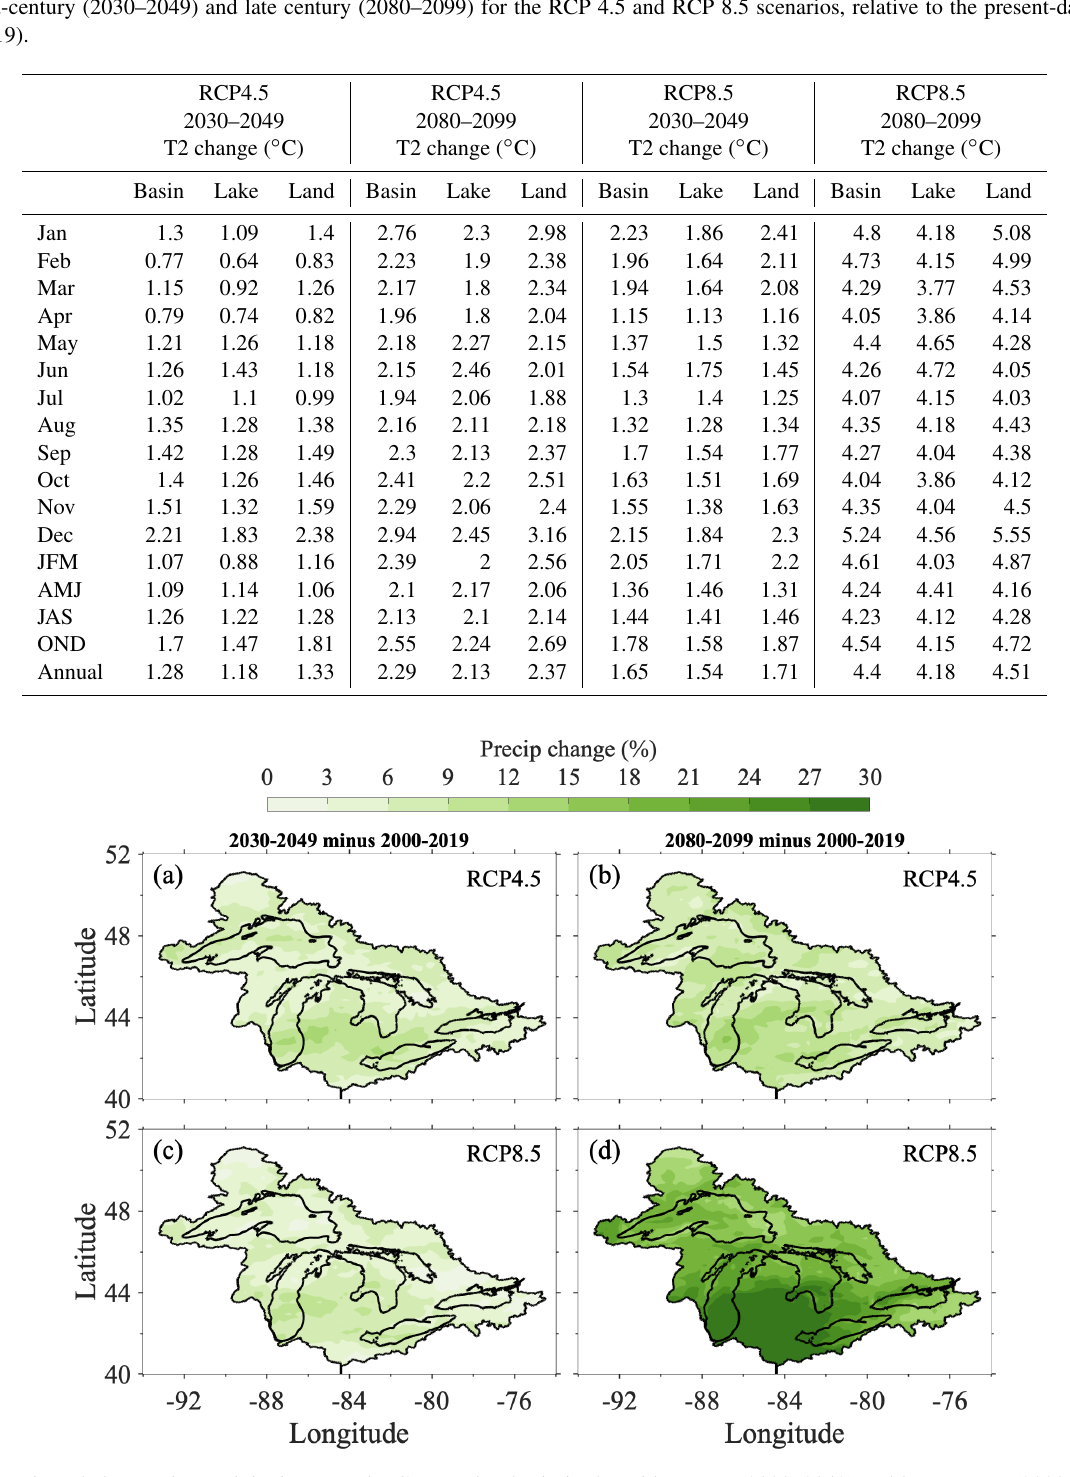
Figure 8. Projected changes in precipitation over the Great Lakes basin in the mid-century (2030–2049) and late century (2080–2099) for the RCP 4.5 (a, b) and RCP 8.5 (c, d) scenarios, relative to the present-day climate